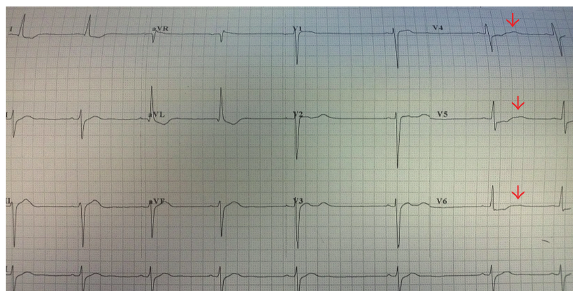
Figure 1: ECG of the patient showing typical u-waves of